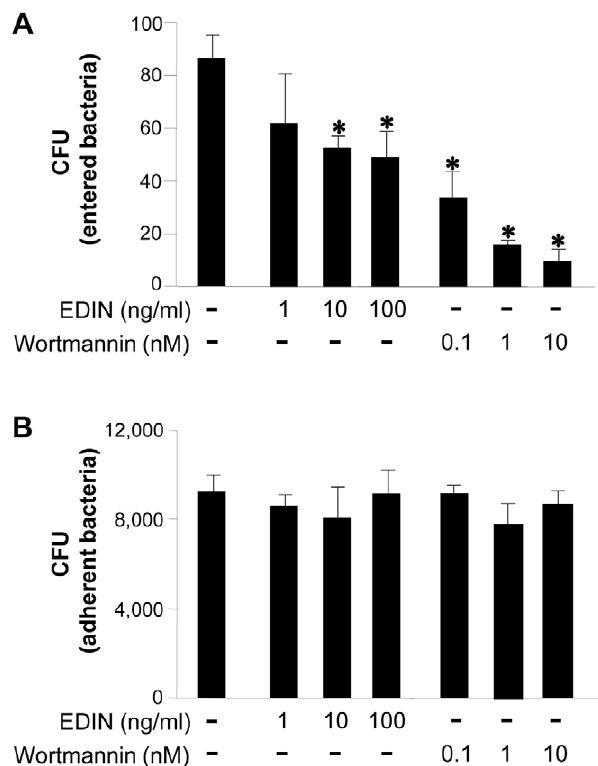
Figure 7. Influence of Rho GTPases inhibitor and PI-3-kinase inhibitor on bacterial entry and attachment to OBA9. Aa harvested at mid-log growth phase was incubated with confluent OBA9 cells (5 6 10 5 bacteria/100 m l/well) in the presence or absence of Wortmannin or EDIN by the indicated concentration in the figures. The number of bacteria that entered or adherent to OBA9 cells is shown (A, bacterial entry; B, bacterial attachment). *, Significantly lower than control medium alone by Student’s t test ( P ,